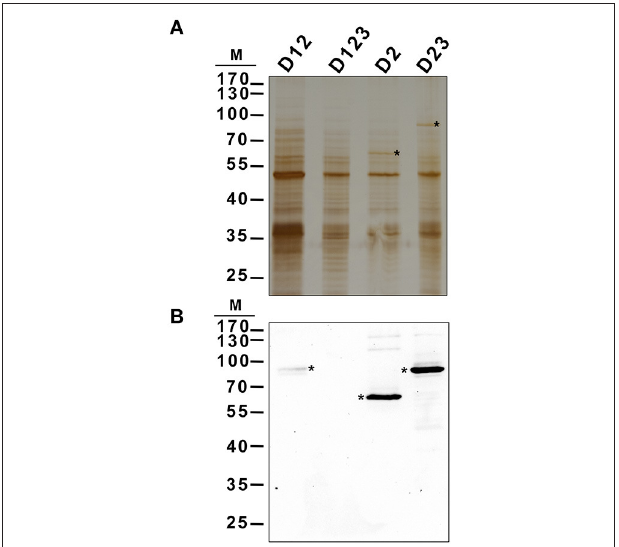
FIGURE 5 | Localization of different AtSS3 truncated versions in starch of agroinfiltrated N. benthamiana leaves. The constructs D12-GFP, D123-GFP, D2-GFP and D23-GFP were transiently expressed in N. benthamiana leaves by agroinfiltration. Infiltrated leaves were harvested and starch was purified, washed and boiled to extract proteins localized in the polymer. 2 µ g of protein were electrophoresed in SDS-PAGE and silver stained (A) or immunoblotted using anti-His5x antibody (B) . Asterisks indicate corresponding polypeptides. M, kDa